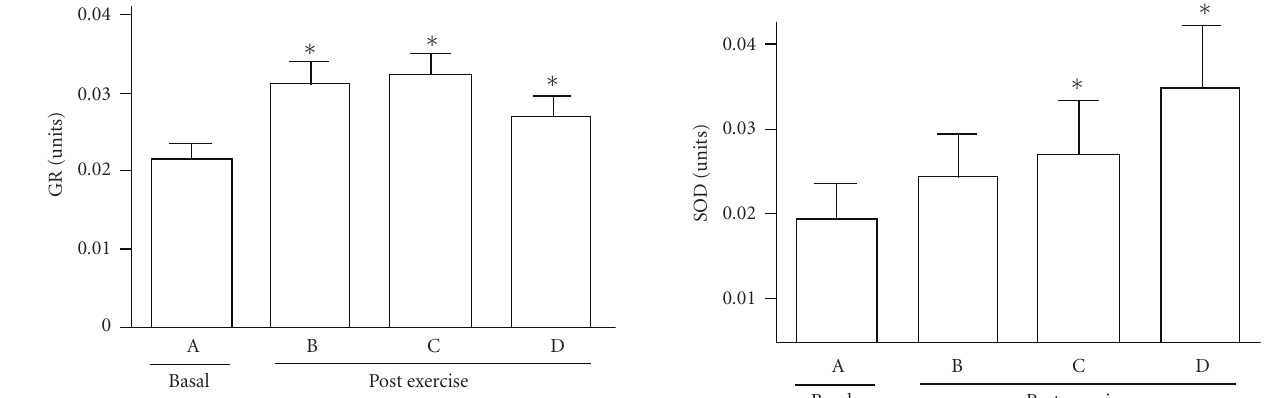
Figure 5: Superoxide dismutase (SOD) activity in plasma from 34 male healthy subjects during basal (A) and immediately after two exercise tests performed until exhaustion (B and C) and a submaximal exercise (D). Data is expressed as mean ± standard error. ∗ denotes statistical di ff erences ( P < . 05) versus basal